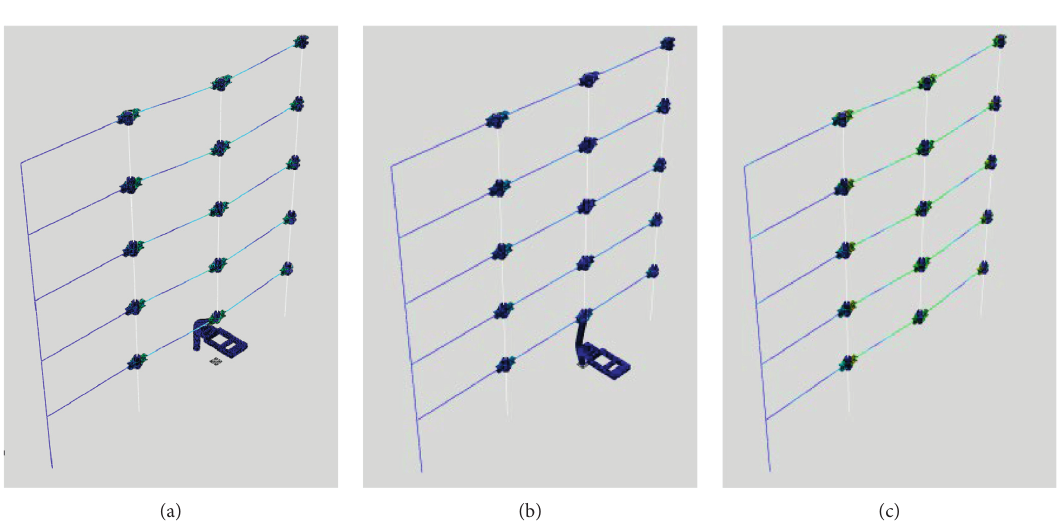
Figure 8: Deformation of the planer frame with the middle column removed. (a) Model c1 via the DS method. (b) Model c25 via the DS method. (c) Model via the AP